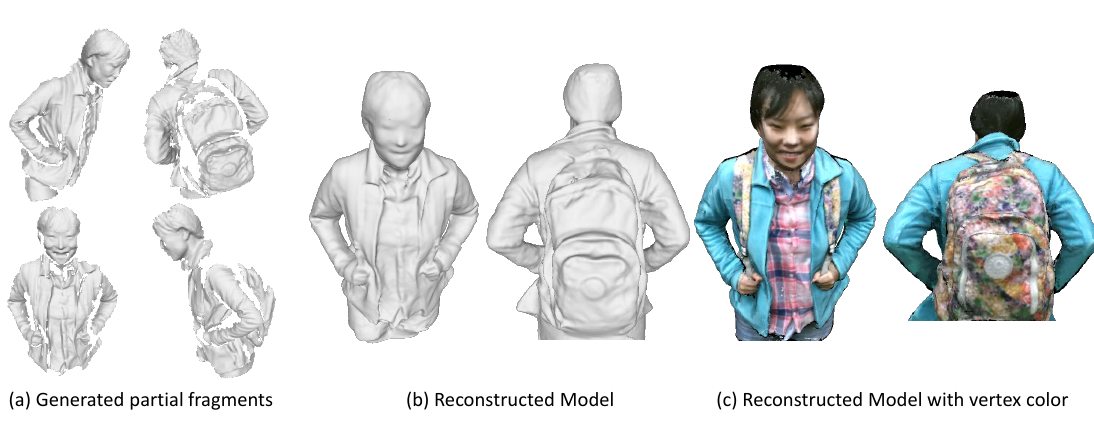
Figure 1. The reconstructed 3D model with our approach. ( a ) some sampled partial scans or fragments; ( b ) the reconstructed model using our approach; ( c ) is our recovered mesh model shown with color